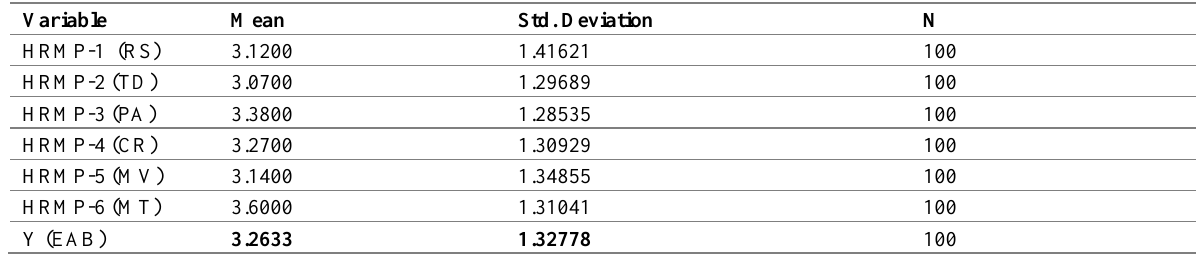
Table 1: Results of The Descriptive